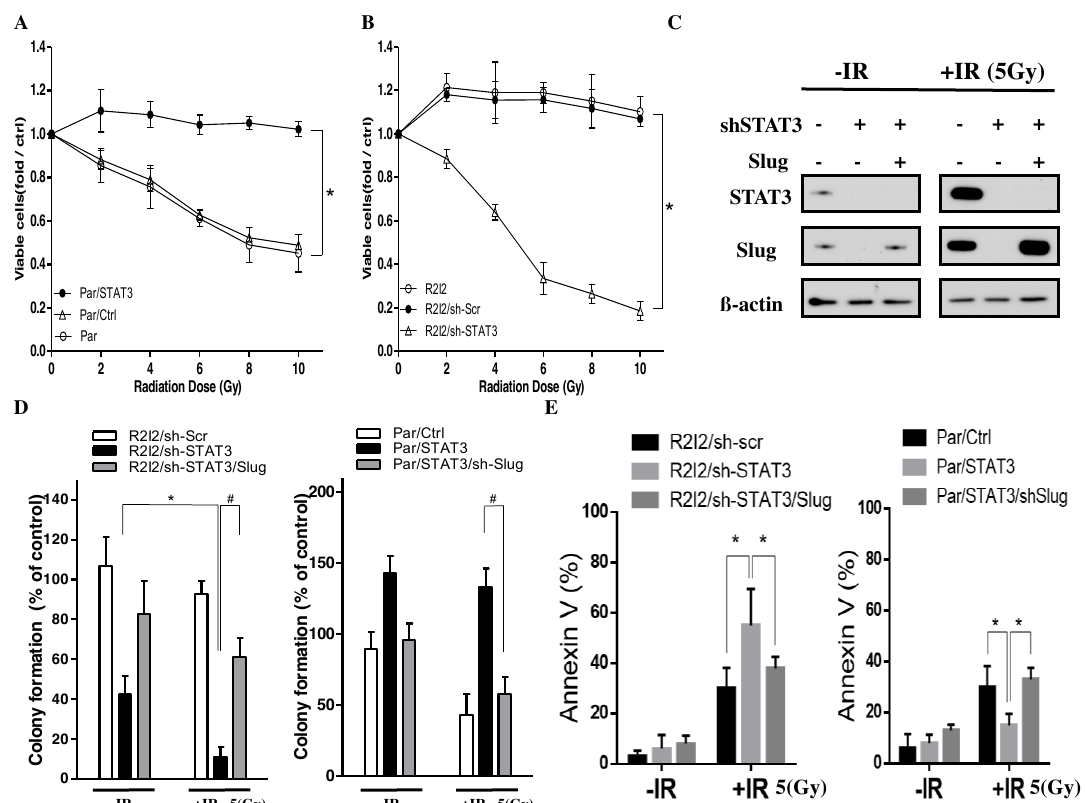
Figure 5. Silencing of STAT3/Slug signaling in combination with ionizing radiation (IR) suppresses cell viability. ( A ) IR doses ranging from 0 to 10 Gy were given to GBM-Par cells with sh-Scr or sh-STAT3, and ( B ) GBM-R2I2 cells with sh-Scr or sh-STAT3. ( C ) Western blotting of GBM cells that were treated with sh-Scr, sh-STAT3, or sh-STAT3/Slug with or without IR (5 Gy). β -actin was used as loading control. ( D ) Colony-forming ability and ( E ) Annexin V staining of GBM-R2I2 cells that were treated with sh-Scr, sh-STAT3, or sh-STAT3/Slug with or without IR (5 Gy); in addition, GBM-Par cells with vector control, ectopic expression of STAT3, or ectopic expression STAT3/sh-Slug were treated with or without IR. * p < 0.01; # p < 0.01 by Student’s t -test. The data are presented as the mean ± SD of 3 independent